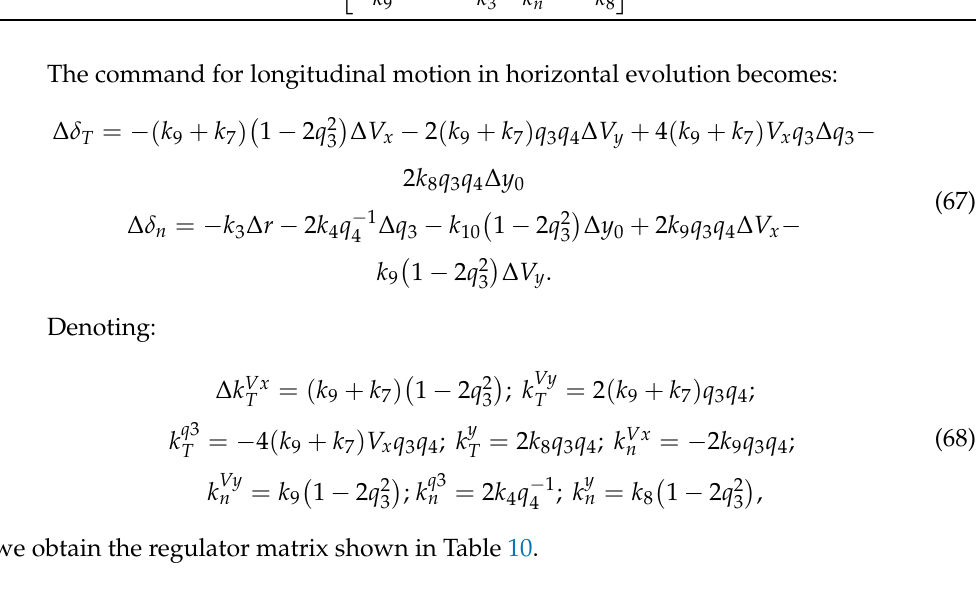
Table 10. The regulator matrix for longitudinal motion in horizontal evolution K